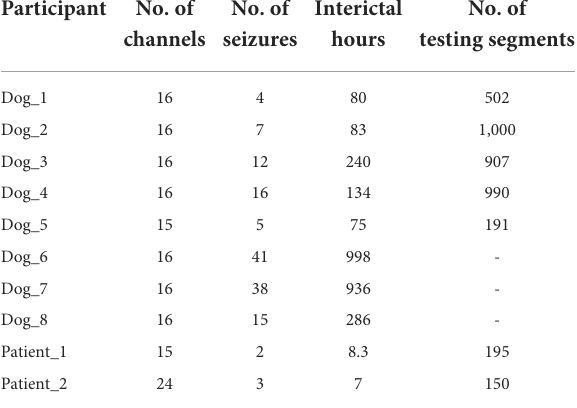
TABLE 1 Description of the Kaggle